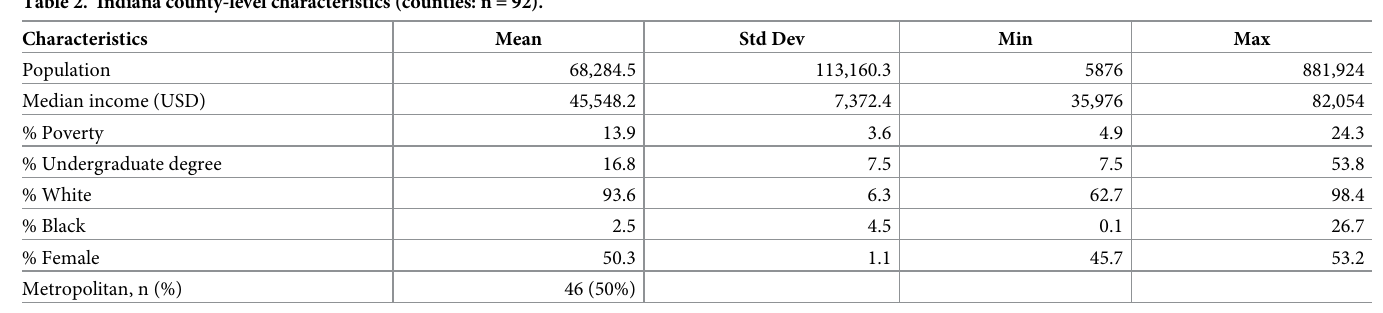
Table 2. Indiana county-level characteristics (counties: n = 92).